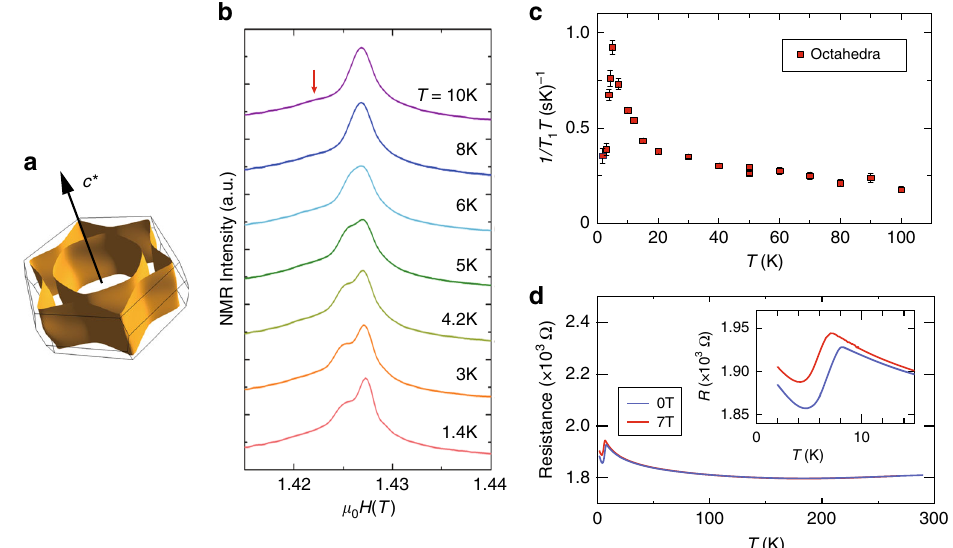
Fig. 3 Physical properties of the (111) p defect structure. a Calculated Fermi surface for 15R-SrVO 2.2 N 0.6 . b 51 V-NMR spectra for SrVO 2.2 N 0.6 at low temperatures. The ordered moment is estimated to be <0.01 μ B . c Temperature dependence of 1/ T 1 T at the octahedral site (red arrow in a ), indicating a magnetic transition at 5 K. Error bars are standard deviation. d Temperature dependence of electrical resistance of the nitridized SrVO 3 fi lm on SrTiO 3 (111) at 0 T and 7 T , characteristic of weak antiferromagnetism due to SDW transition at around 8